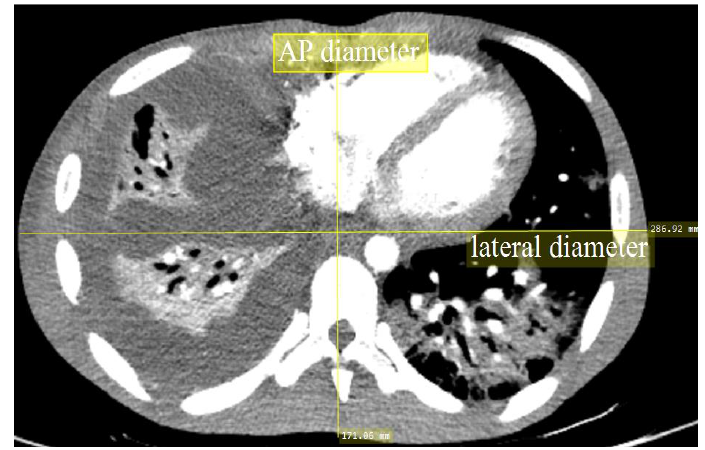
Figure 1. A patient’s anteroposterior (AP) measurement at the mid-slice of the 3D computed Figure1. Apatient’santeroposterior(AP)measurementatthemid-sliceofthe3Dcomputedtomography tomography (CT) images. (CT)